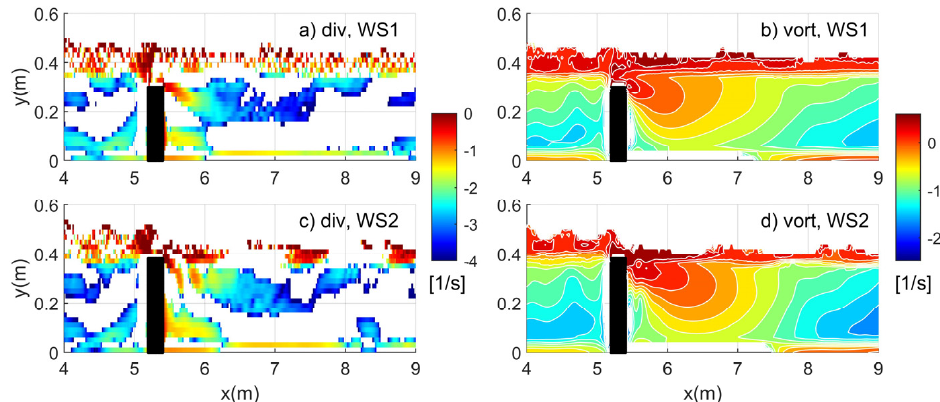
Figure 5. Divergence ( a , c ) and clockwise vorticity ( b , d ) in log scale for WS1 and WS2. The submerged structure is marked as black bars. The region of convergence in ( a , c ) and the counter-clockwise vorticity in ( b , d ) has no color. The legends indicate the log of divergence and convergence.